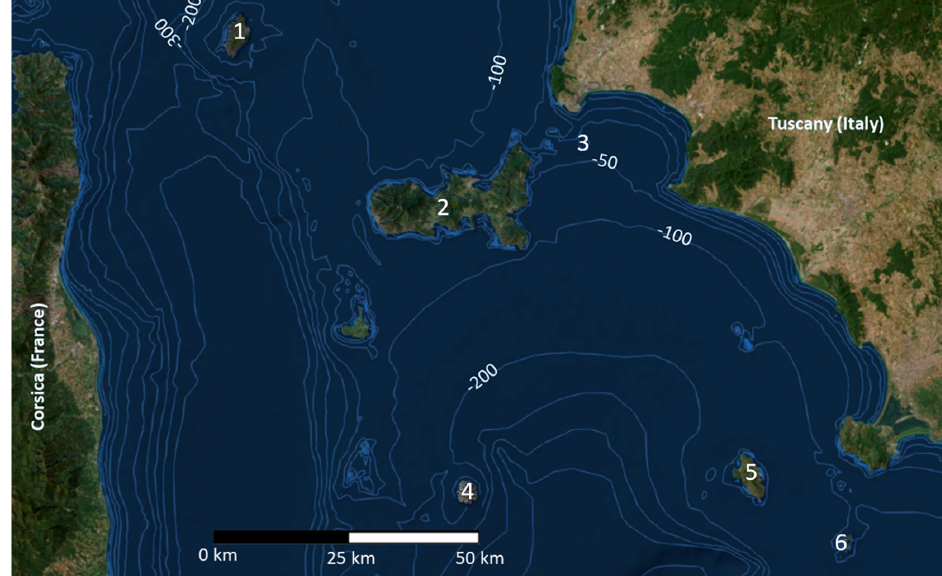
Figure 1. Map of the Tuscan Archipelago. 1: Capraia, 2: Elba, 3: Cerboli, 4: Montecristo, 5: Giglio, 6: Giannutri. Bathymetric map from the open source database of ISPRA (The Italian Institute for Environmental Protection and Research, http://sgi2.isprambiente.it/mapviewer/, accessed on 18 January 2023), modified by Claudia Corti and Andrea Savorelli (Natural History Museum of the University of Florence).